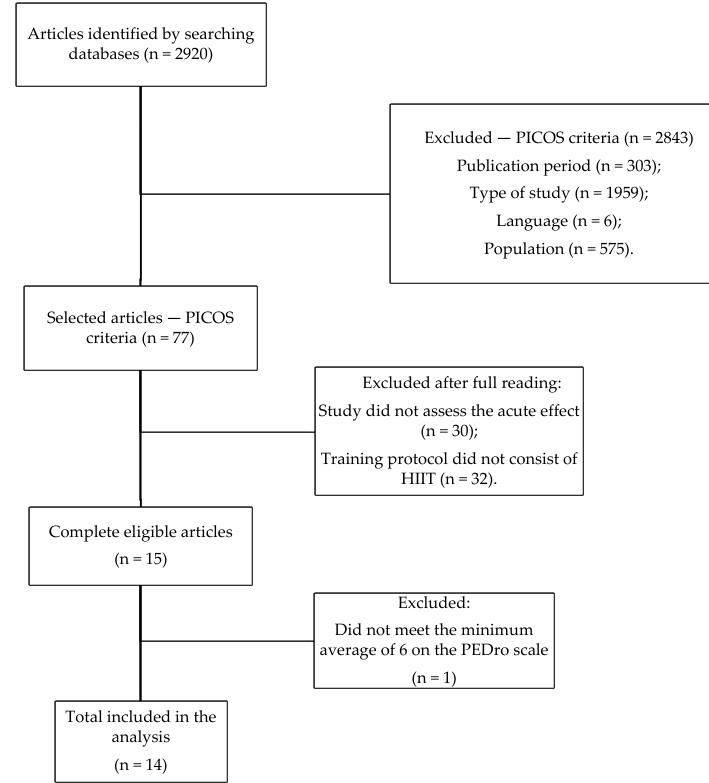
Figure 1. PRISMA flowchart for the search and selection of